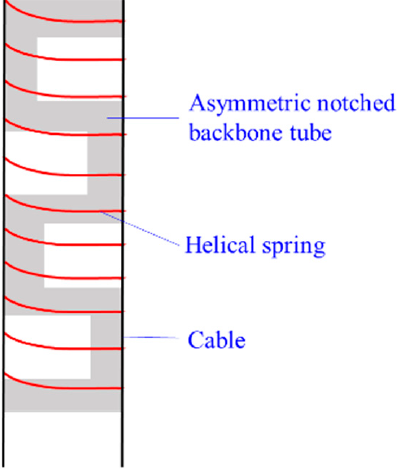
Figure 15. The design of the notched backbone-spring CCRs [86].